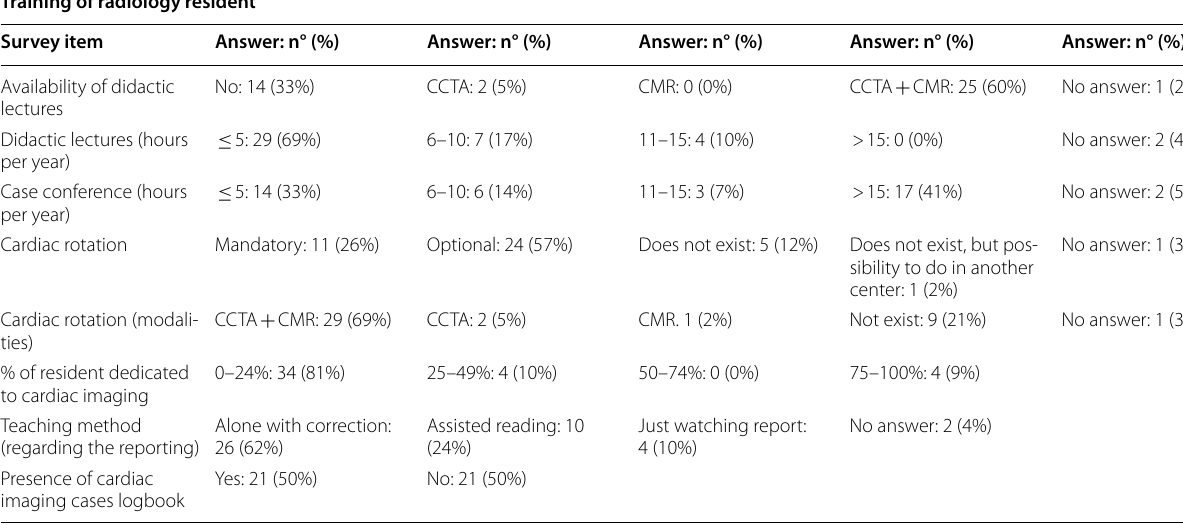
Table 3 Questions and answers on the training of radiology